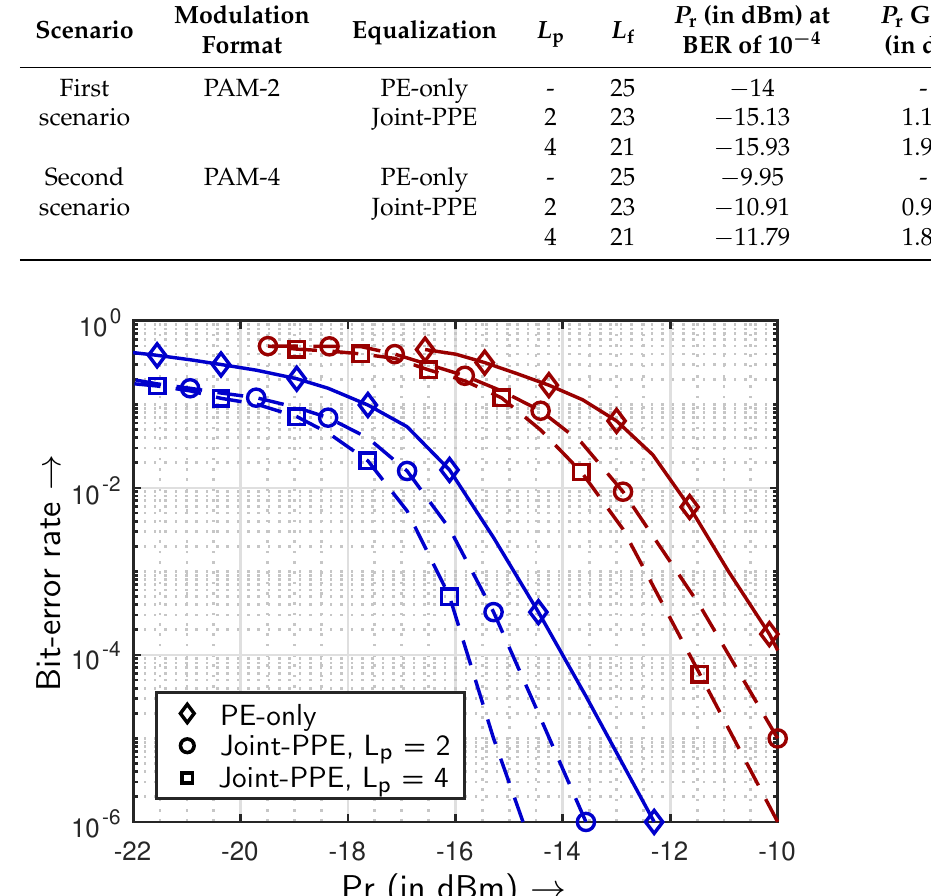
Figure 8. BER in dependence on the average optical received power while using a 100 m long MMF channel and MMSE equalizer, where PAM-2 and PAM-4 are depicted with blue and red color respec- tively.